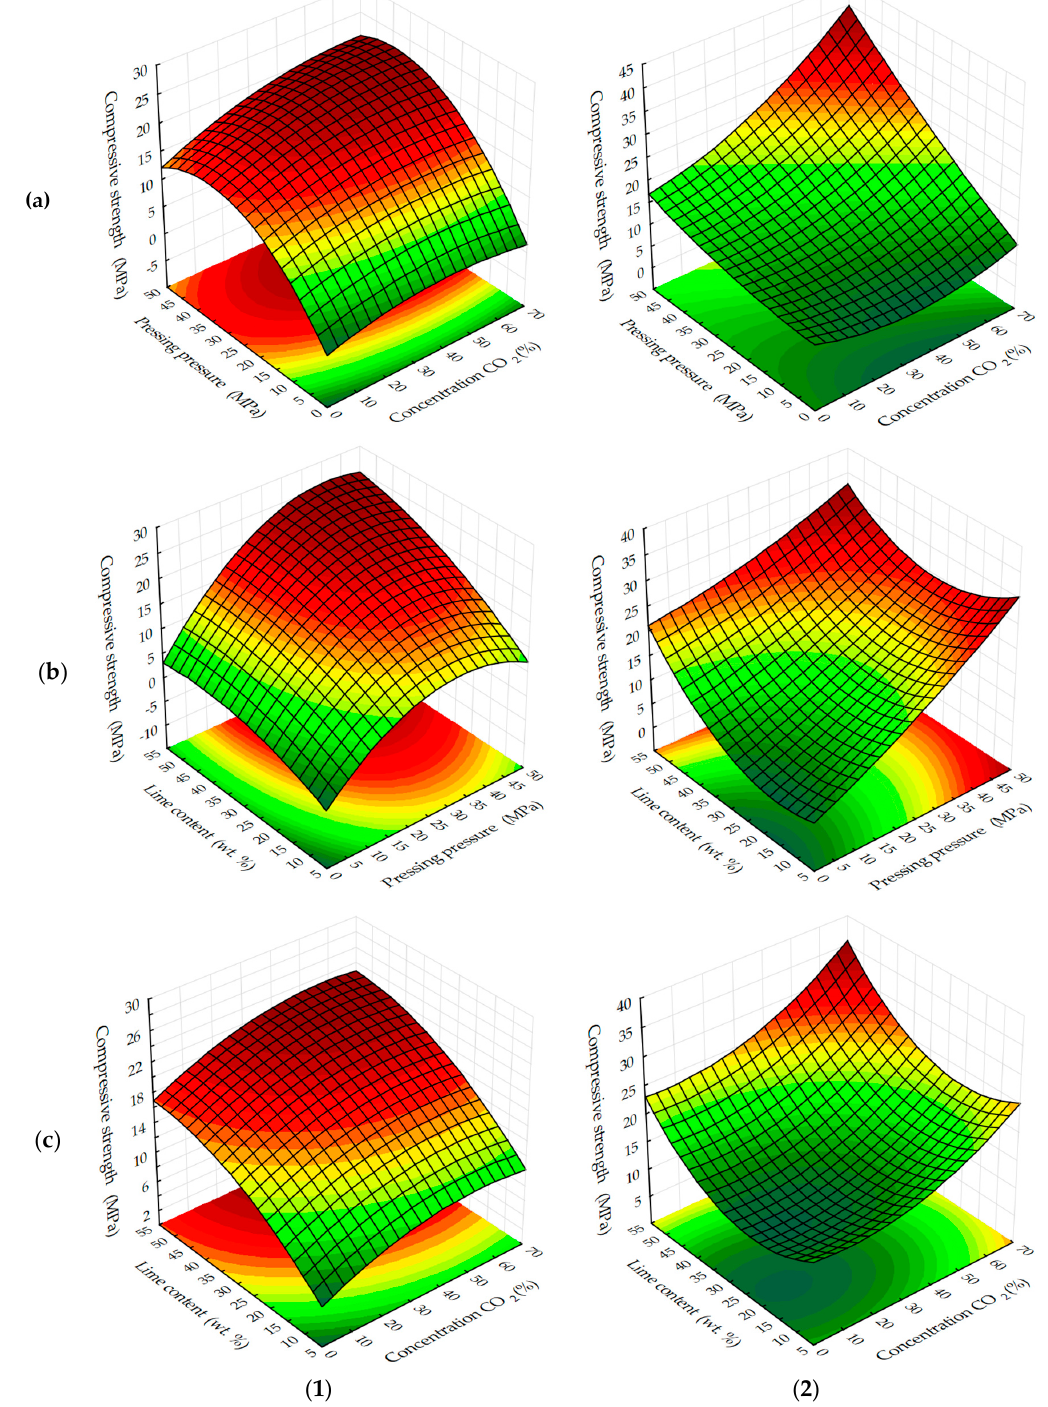
Figure 3 : Compressive strength response surfaces of testing samples carbonated by dynamic ( 1 ) and static ( 2 ) methods, depending on: ( a ) pressing pressure; ( b ) lime dust content; ( c ) CO 2 concentration (at zero level of variation of other factors).